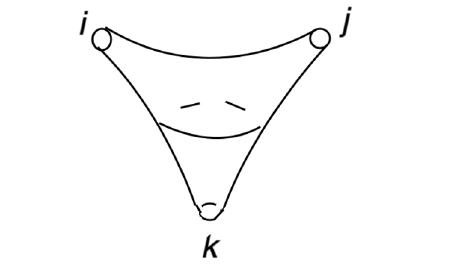
Figure 1 . A three-holed sphere, with its boundaries labeled by fixed energy states i, j, k .